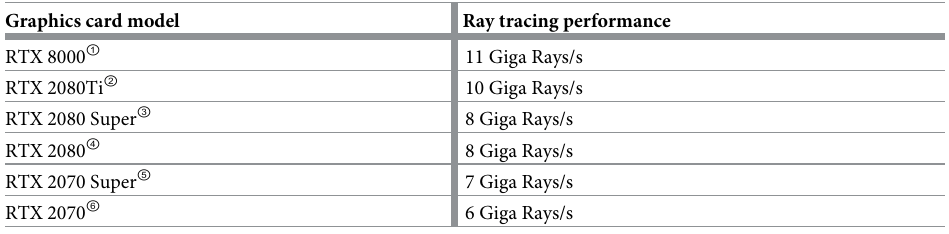
Table 1. The ray tracing performance of different graphics